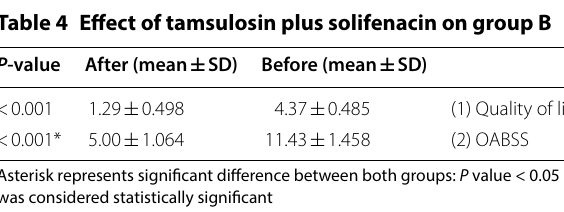
P -value After (mean < 0.001